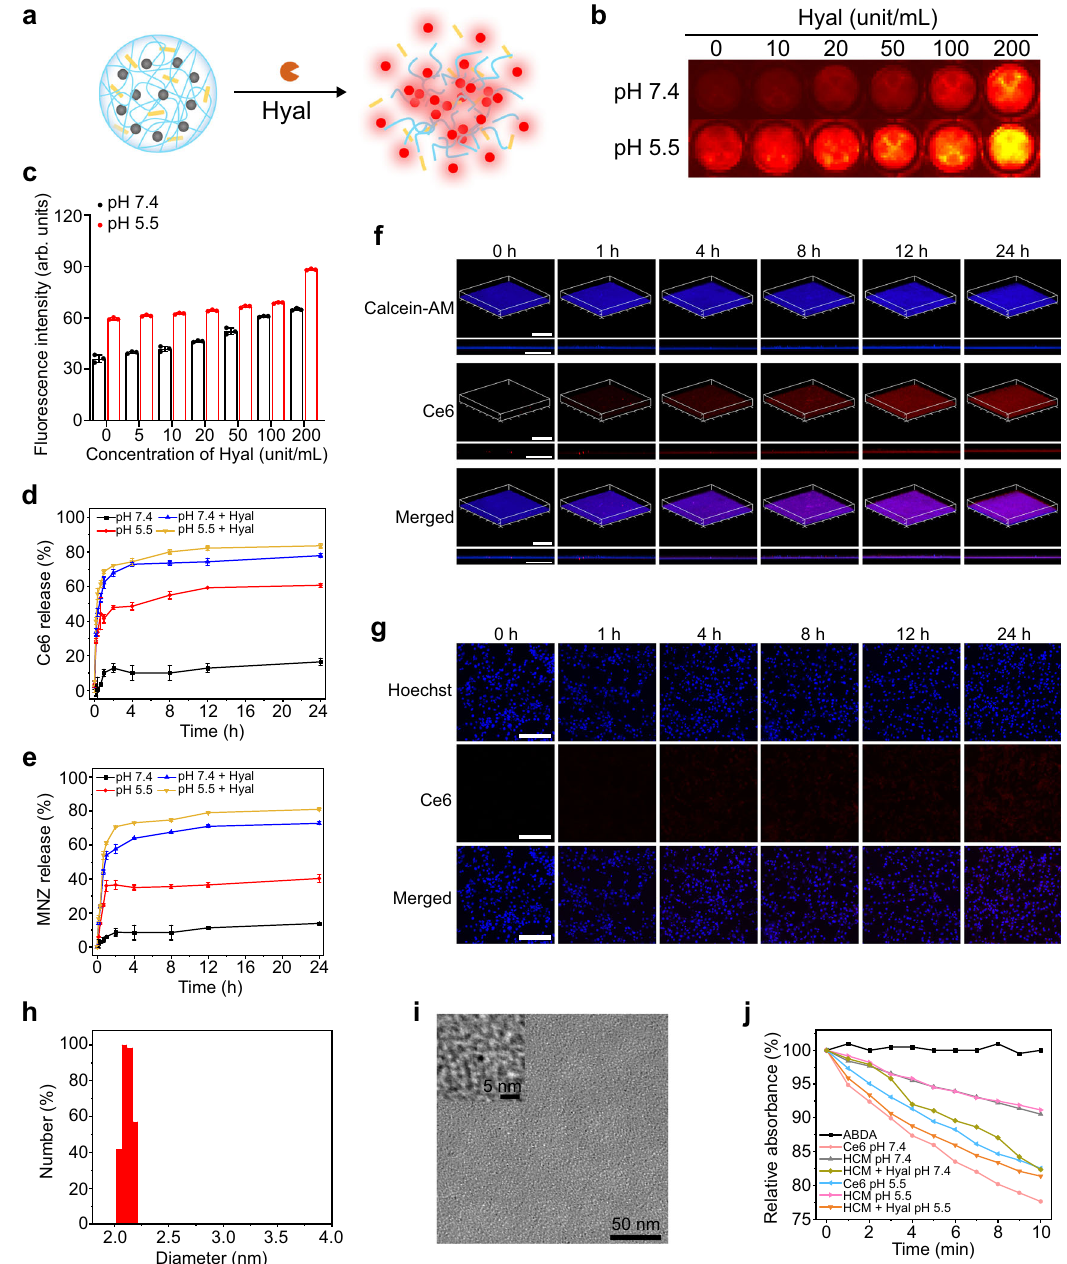
Fig. 3 Hyal-responsive drug release of HCM NPs. a Scheme of the decomposition of HCM NPs in presence of Hyal. Fluorescence images ( b ) and corresponding fl uorescence intensity ( c ) of HCM NPs (Ce6: 40 μ g/mL) after incubation with Hyal at different concentrations for 12 h ( n = 3 independent samples; mean ± SD). Release of Ce6 ( d ) and MNZ ( e ) from HCM NPs (Ce6: 40 μ g/mL; MNZ: 20 μ g/mL) under different conditions ( n = 3 independent samples; mean ± SD). The confocal laser scanning microscopy (CLSM) images of MRSA bio fi lms ( f ) and SMCs ( g ) after incubation with HCM NPs (Ce6: 50 μ g/mL; MNZ: 25 μ g/mL) for different times. Scale bar is 200 μ m. Hydrodynamic size ( h ) and TEM images ( i ) of HCM NPs after incubation with Hyal (100 unit/mL) for 24 h. j Relative absorbance of ABDA at 380 nm (OD 380 ) after incubation at various conditions under laser irradiation (635 nm, 20 mW/ cm 2 ) for different times. Three independent experiments were performed and representative results are shown in f , g , and i . Source data are provided as a Source Data fi